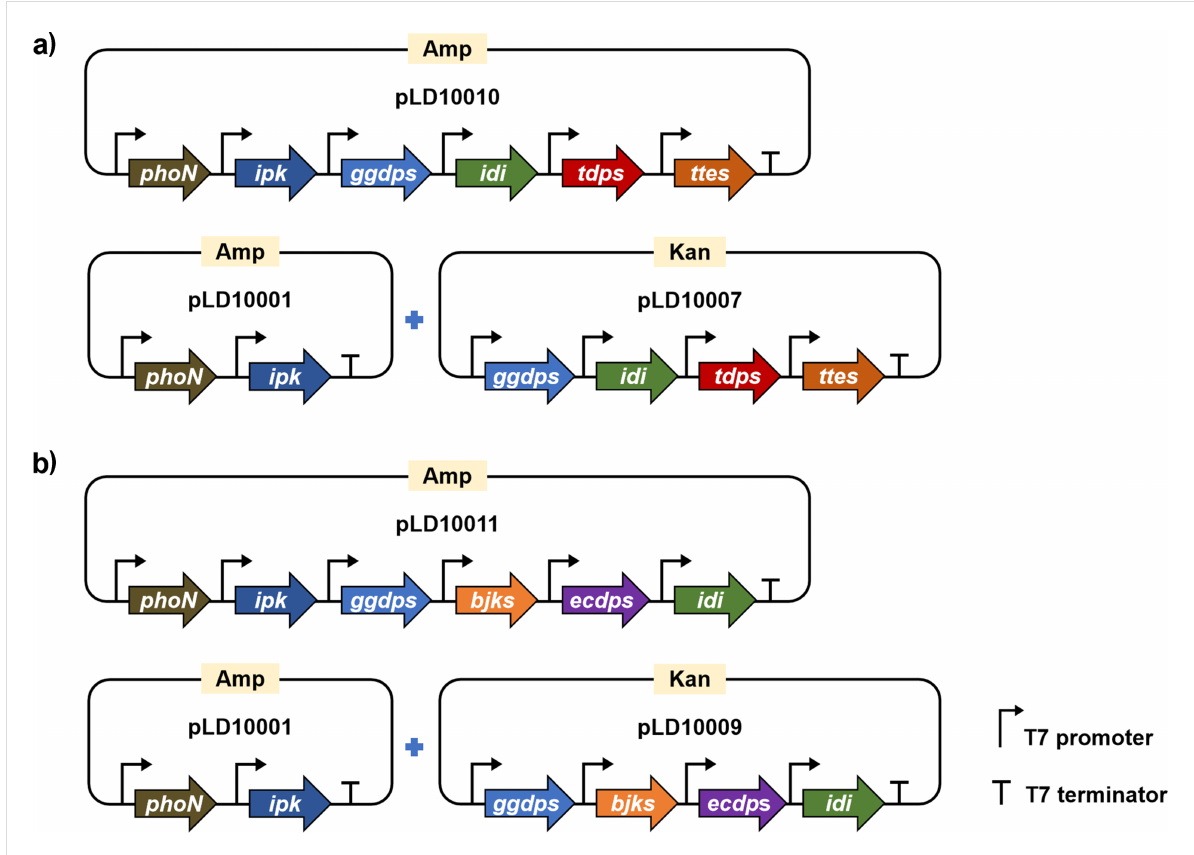
Figure 3: Construction maps of single plasmid expression system and two-plasmid expression system for overproducing terpentetriene (a) and ent -kaurene (b) in E. coli .